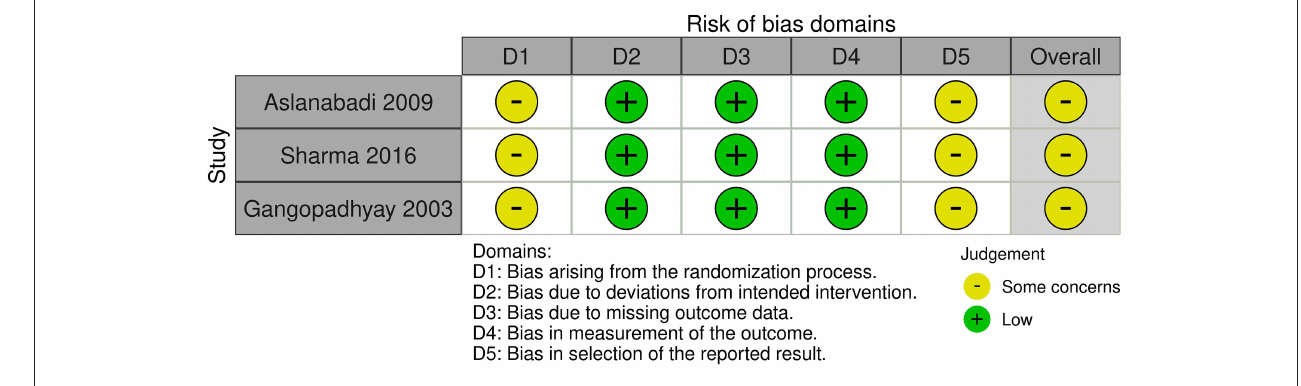
FIGURE 2 | Risk of bias assessment.